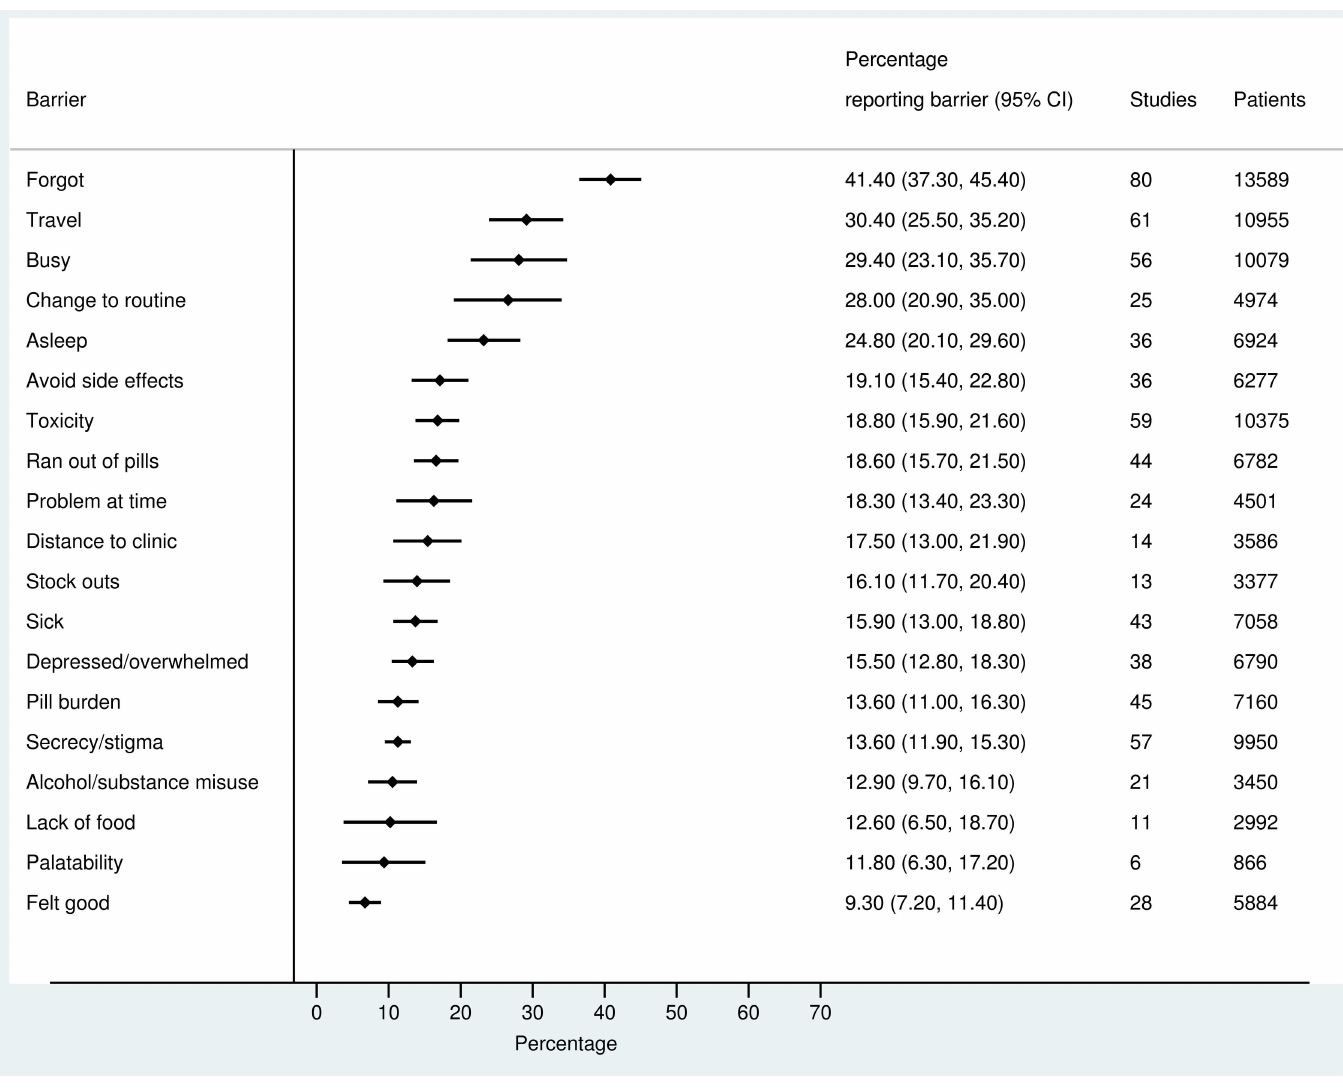
Fig 2. Barriersto adherence among adults on